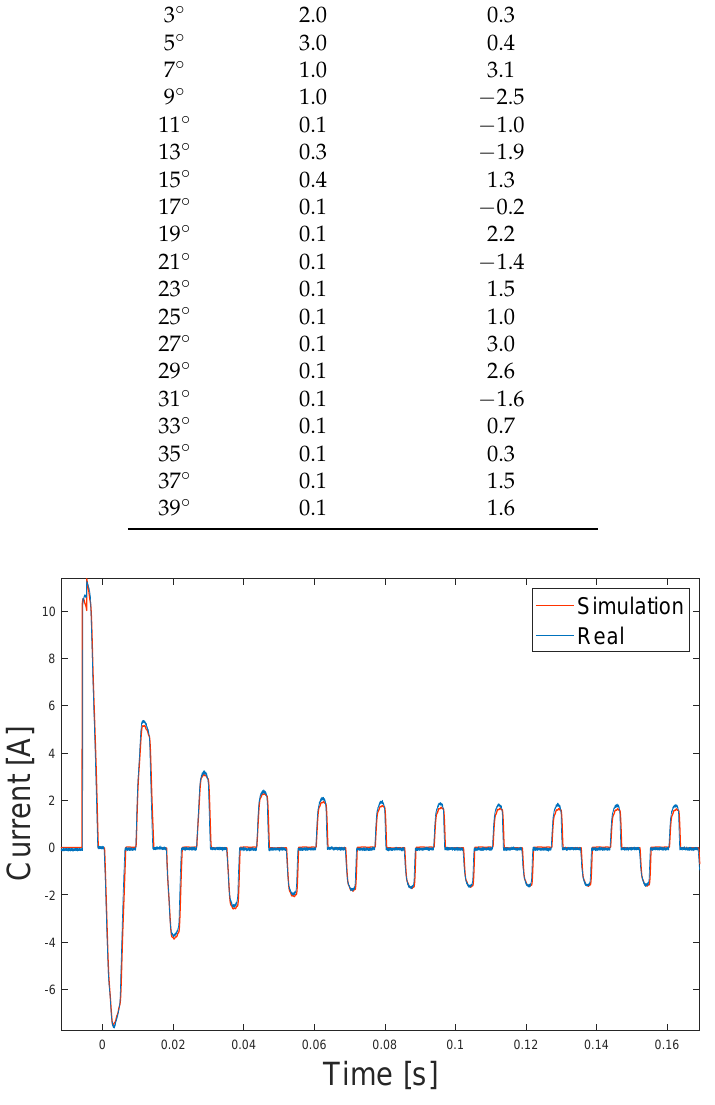
Figure 18. Measured and simulated current of the full-wave bridge rectifier load. Adapted from [10]. Table 13. Validation parameters (absolute current and voltage peak